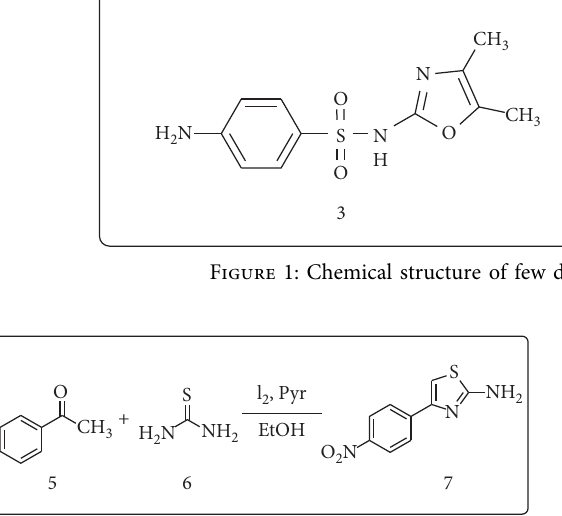
Scheme 1: Synthesis of compound 7